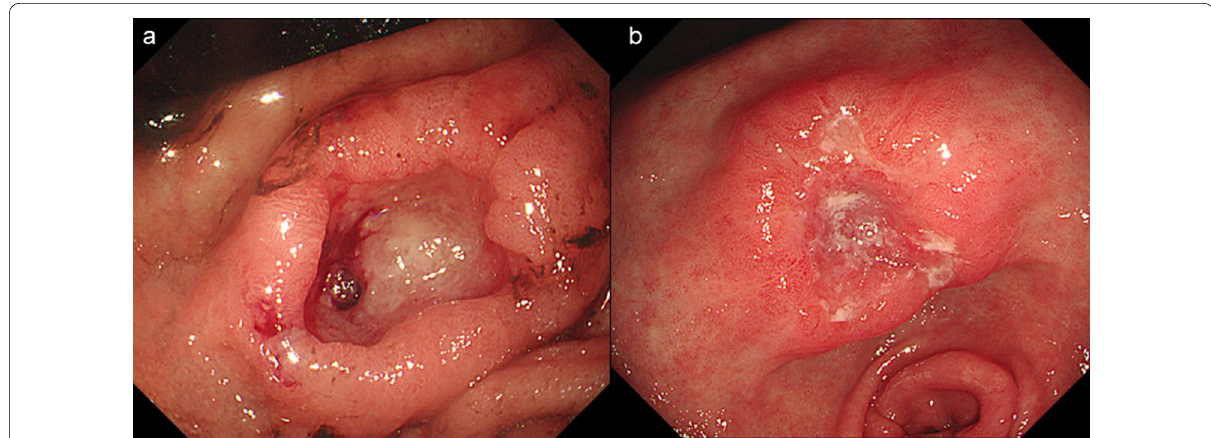
Fig. 1 Endoscopy findings. a Emergency endoscopy at the first admission. A hemorrhagic gastric ulcer was found in the lesser curvature of the antrum. b Follow-up endoscopy showed a tumor-like lesion in the lesser curvature of the antrum that was diagnosed as well-differentiated adenocarcinoma by biopsy